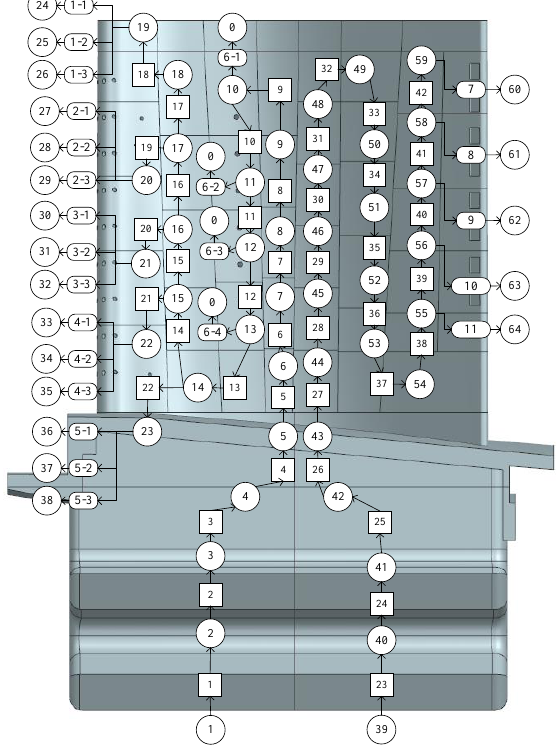
Figure 25. Topological model diagram of blade flow